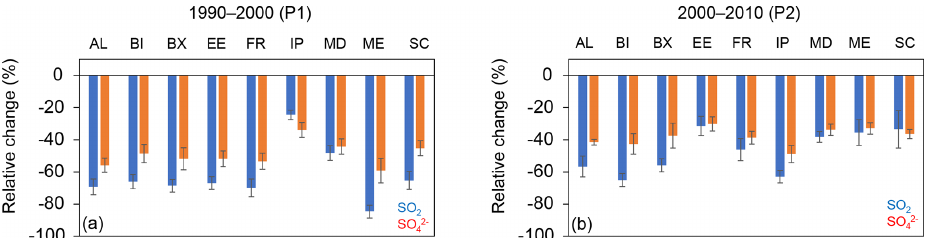
Figure 13. Modeled relative trends in SO 2 and SO 2 − periods. The columns show the averages (over land) of all the model estimates and the bars show the standard deviation with respect to the